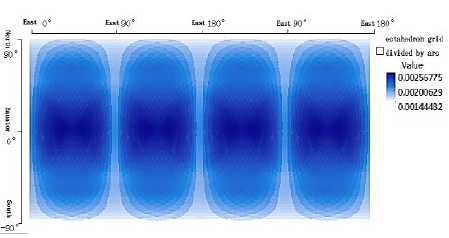
Figure 18. Mean square error of the electrical potential energy of the spherical diamond discrete grids